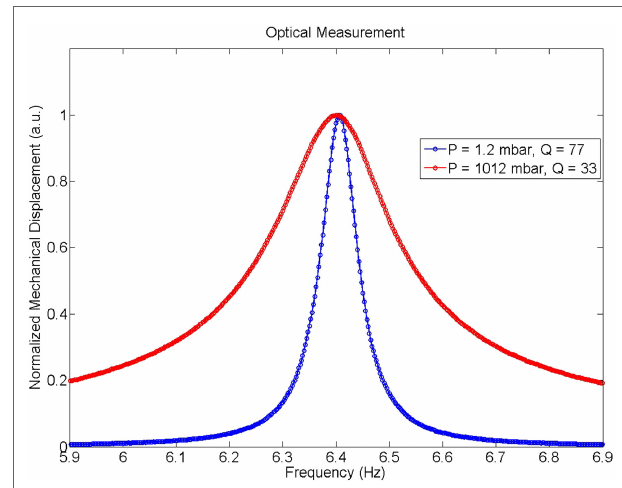
FigUre 7 | Frequency response of the first cavity in vacuum (blue line, P = 1.2 mbar, Q vacuum = 77) and in atmospheric pressure (red line, P = 1012 mbar, Q air = 33) . The amplitude of both curves has been normalized due to difference in optical measurement